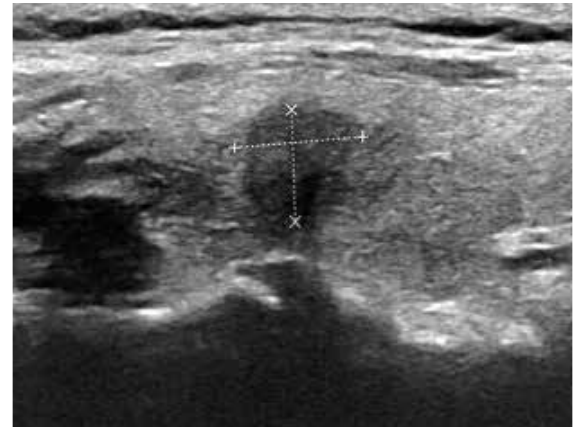
Figure 2 Ultrasonographic appearance of PTMC showing the apparent hypoechogenicity, unclear border, the aspect ratio > 1, and anteroposterior diameter > 0.7